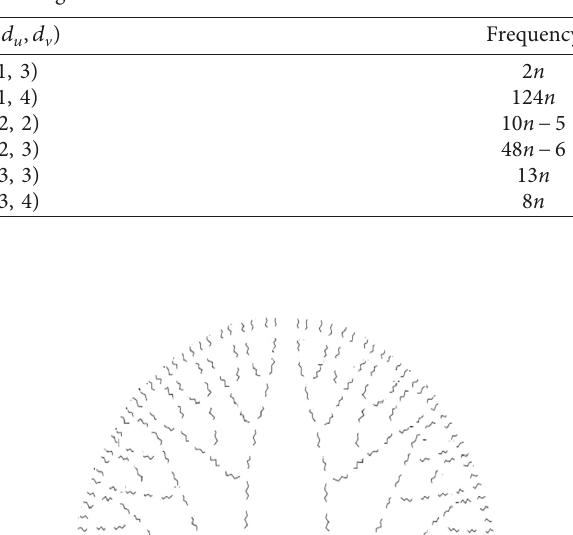
Figure 3: Zinc Prophyrin Dendrimer DPZ Table 3: Degree-based edge partition of DPZ each edge.